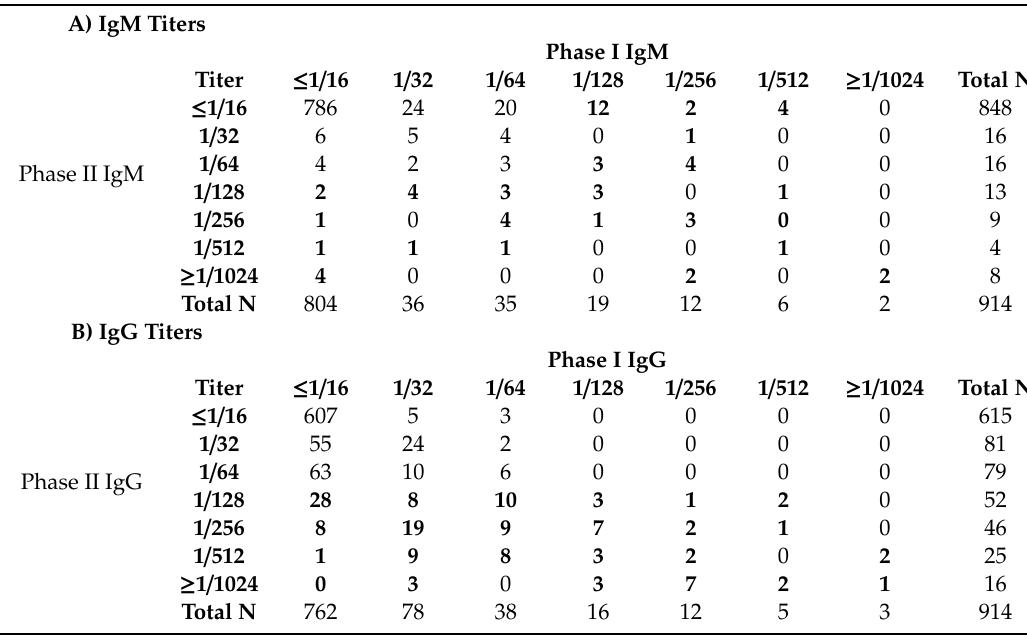
Table 1. Immunofluorescence assay (IFA) titers of IgM and IgG antibodies to Coxiella burnetii phase I and II antigens in the 914 specimens of the outbreak. Titers in bold indicate the number of specimens with elevated phase I and / or II ( ≥ 1 / 128).